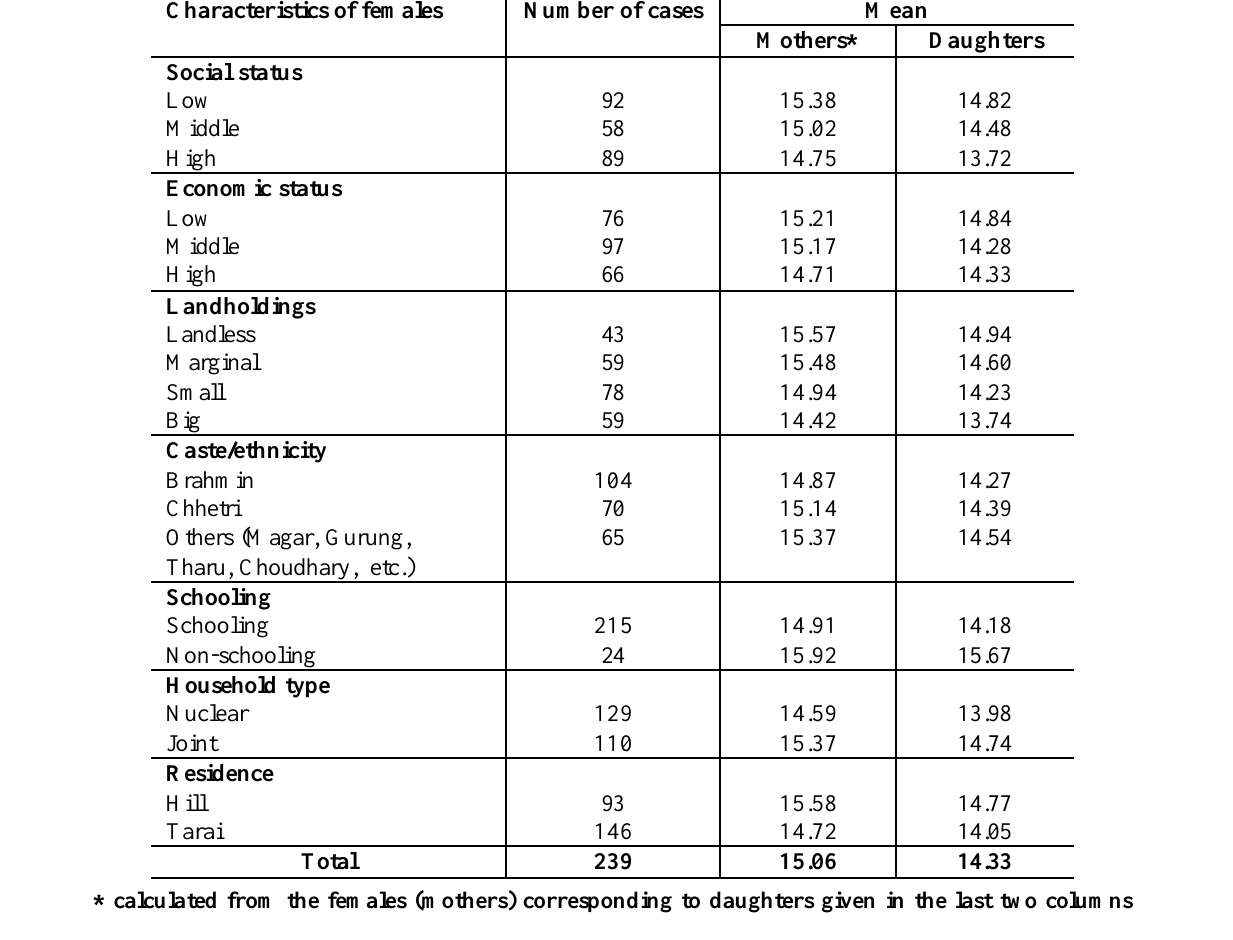
Table I : Mean age at menarche according to the characteristics of females (mother and daughter)